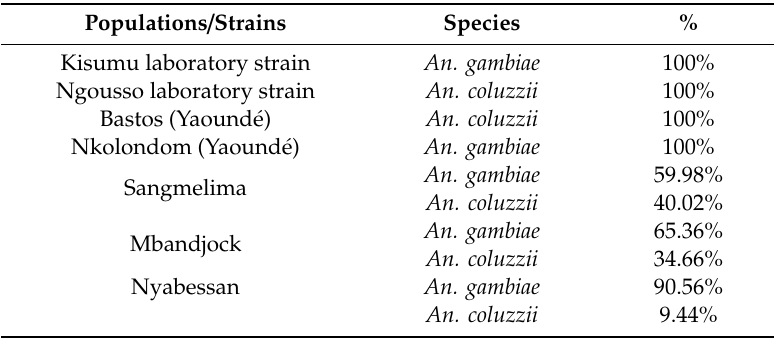
Table 2. Distribution of An. Gambiae s.l. species in the di ff erent study sites. Populations / Strains Species %